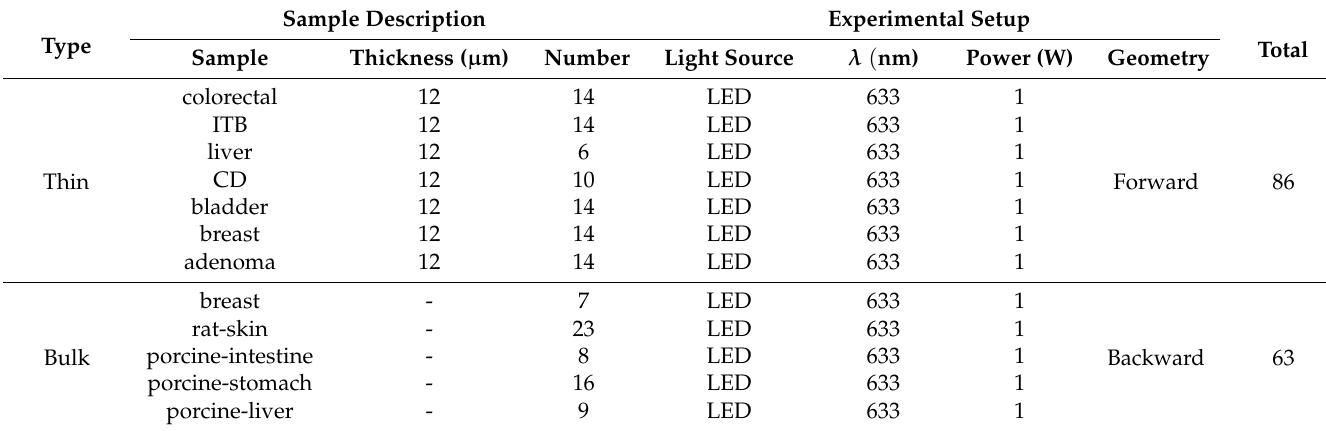
Table 1. Description of the tissue samples ( n = 149) and the experimental setup of the Mueller matrix polarimetry systems. Sample Description Experimental Setup Type